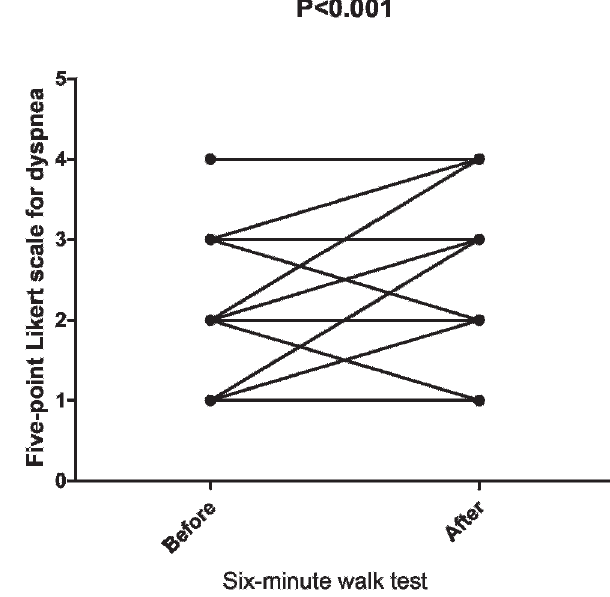
Figure 1 - Five-point Likert scale for dyspnea before and after